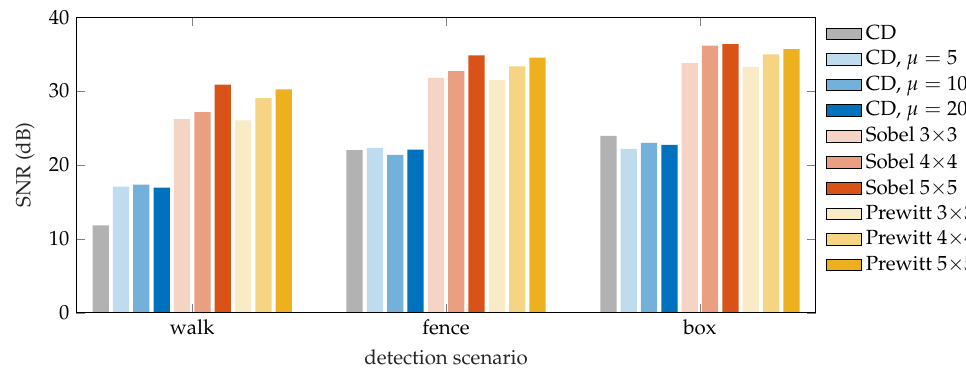
Figure 9. SNR results of the vibration localization for compared algorithms.